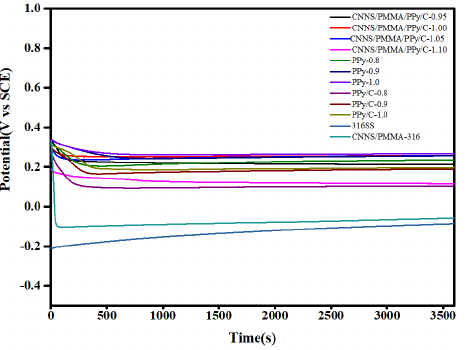
Figure 2. The E ocp values versus time curves for bare 316SS and coated 316SS for 1 h immersion.